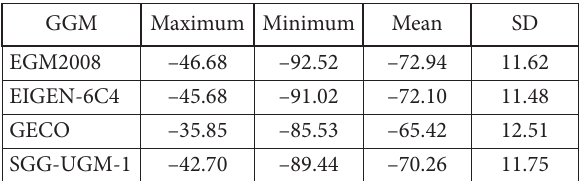
Table 2. Statistics of the differences between observed and GGMs implied free-air gravity anomalies over Kenya at